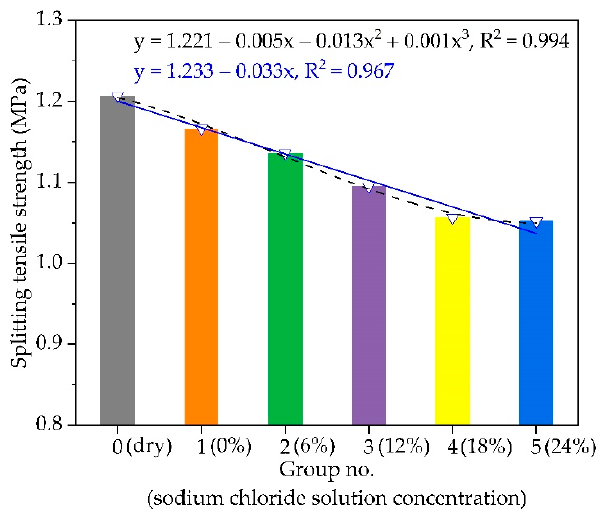
Figure 6. The variation of low-temperature IDT strength with different chloride salt concentrations.